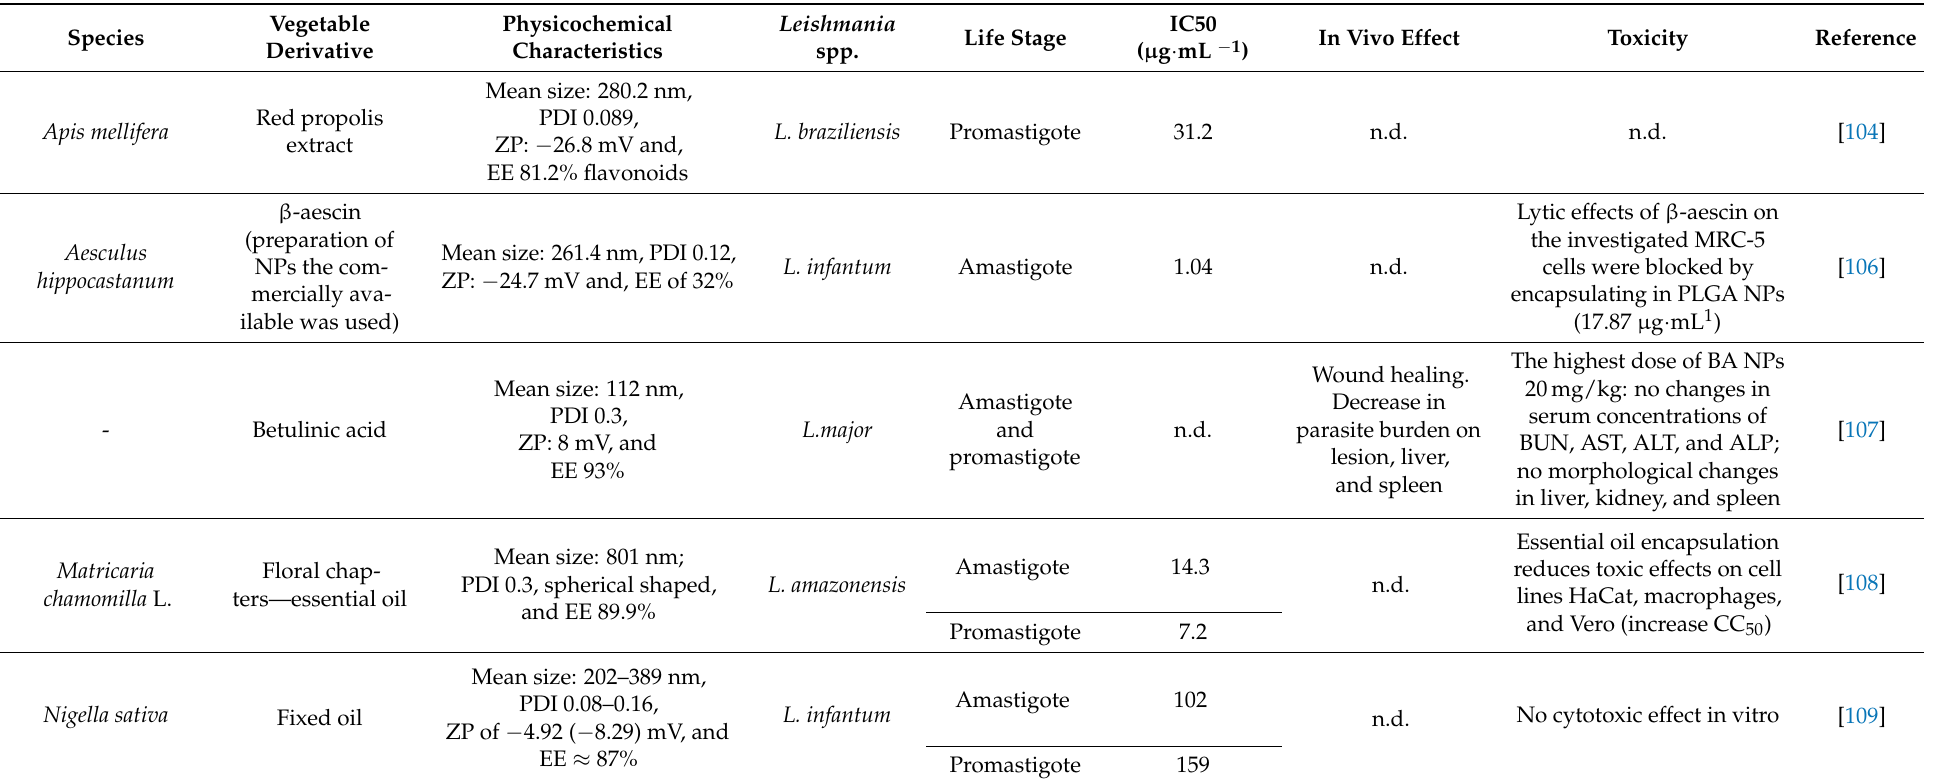
Table 4. Plant-based polymeric nanoparticles as antileishimanicidal